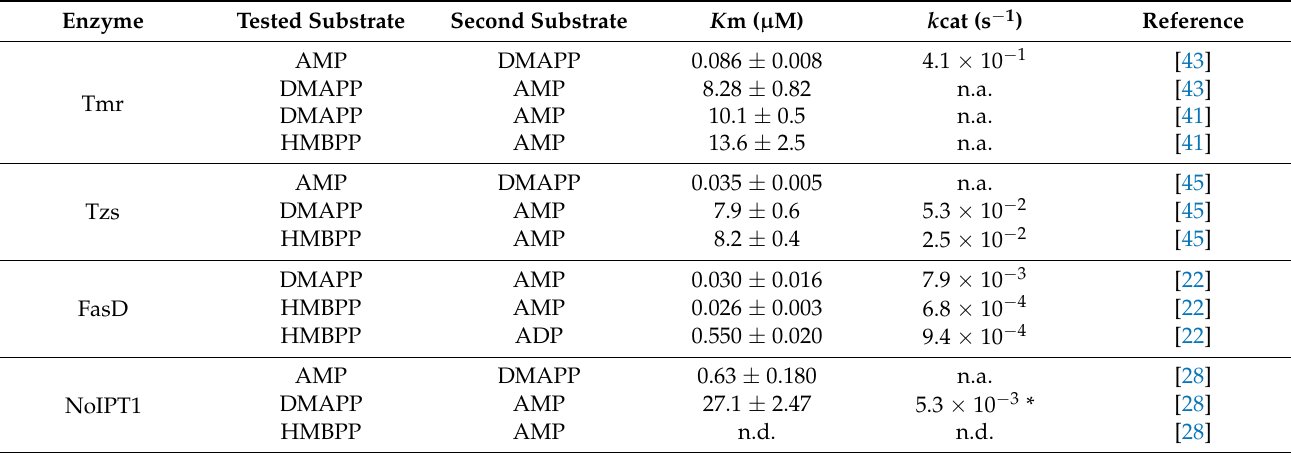
Table 1. Kinetic parameters of bacterial isopentenyl